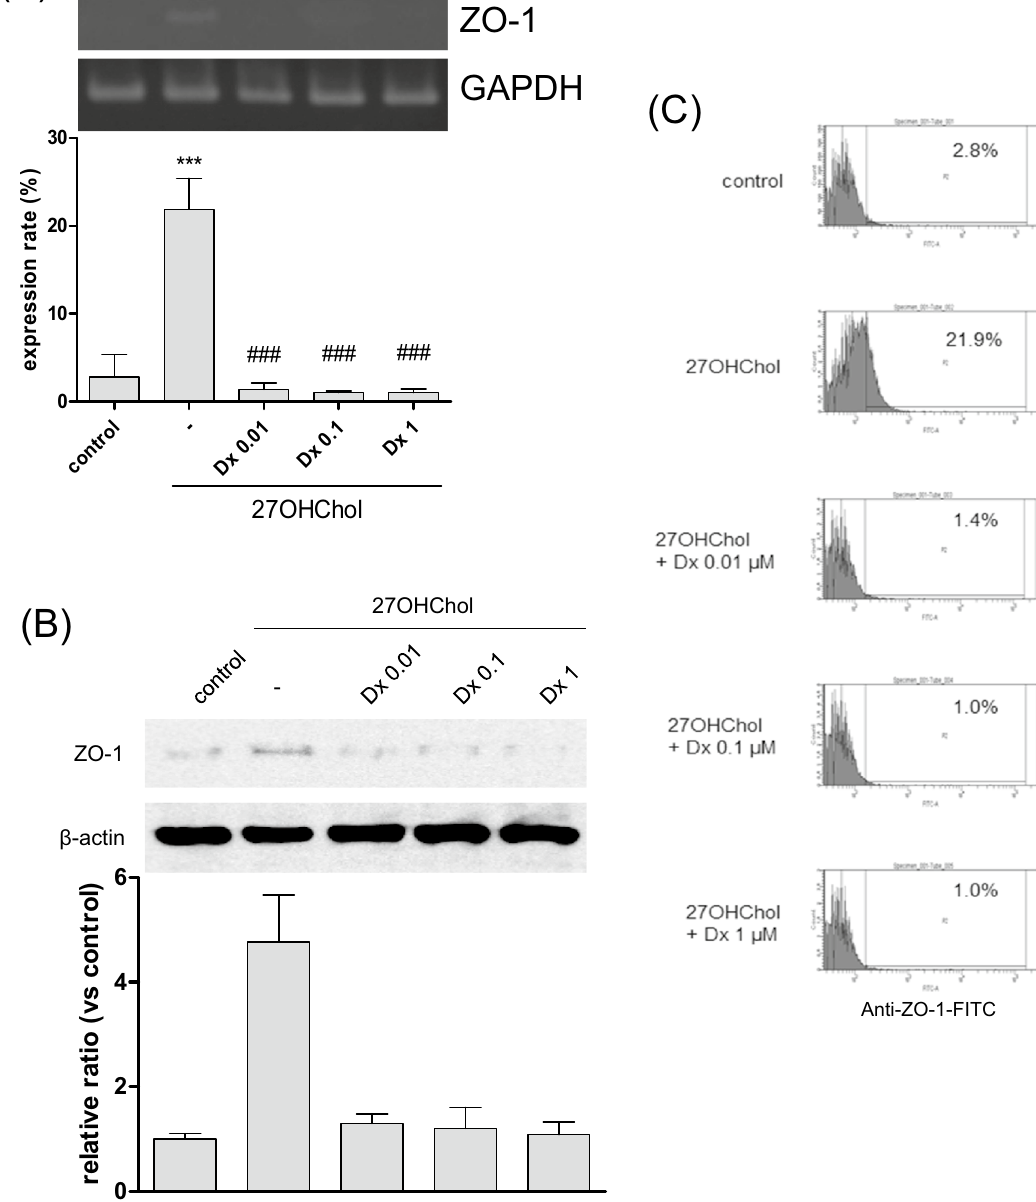
Figure 6. Effects of Dx on the 27OHChol-induced ZO-1 expression. THP-1 cells were stimulated with 2.5 µg/ml of 27OHChol in the presence of 0.01, 0.1, and 1 μM dexamethasone (Dx) for 48 h. ( A ) The levels of ZO-1 transcripts were analyzed by RT-PCR and quantitative real-time PCR. *** P < 0.01 versus control; ### P < 0.01 versus 27OHChol; # P < 0.1 versus 27OHChol. ( B ) Proteins harvested from the cells were analyzed via Western blot to detect ZO-1. ( C ) The cells, treated with 27OHChol and indicated concentration of Dx, were immunostained with fluorescence-conjugated antibodies against ZO-1 and analyzed by flow cytometry. The results are representative of three independent